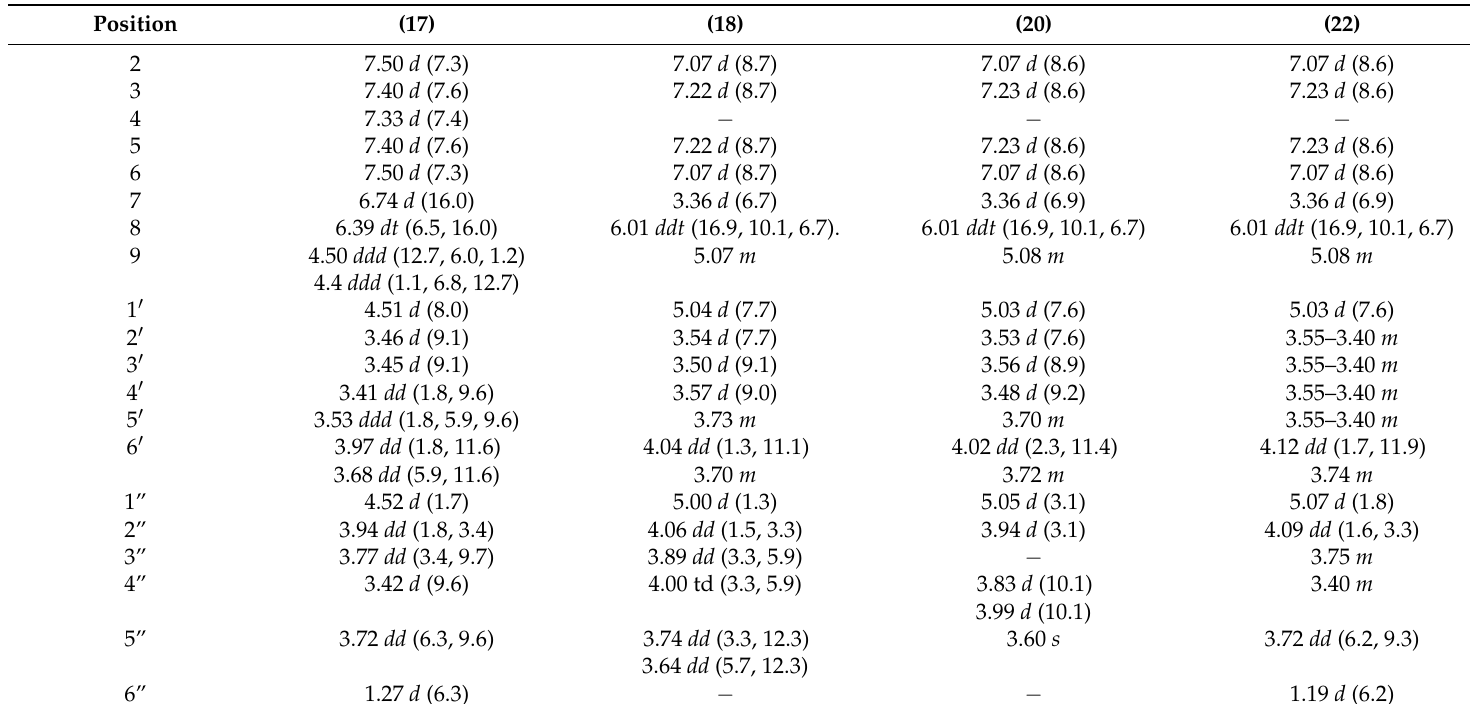
Table 3. 1 H-NMR data of cinnamyl and chavicol disaccharides found in S. triandra × dasyclados hybrid (NWC1283) wood chip